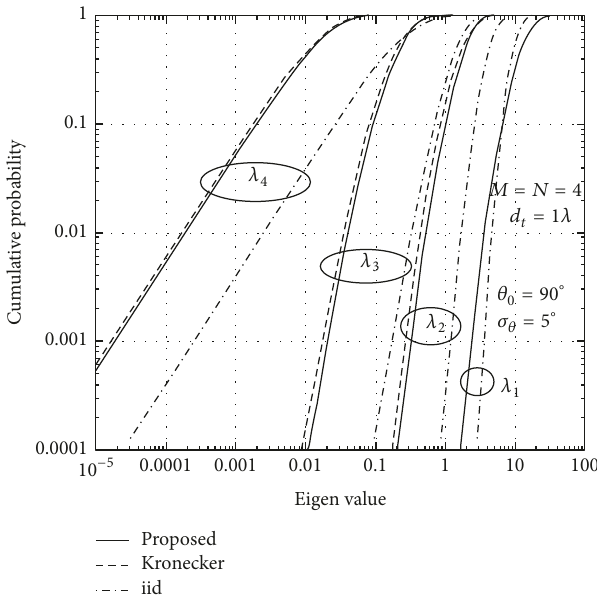
Figure7:EigenvaluecharacteristicswhentakingtheTX-sidespatial correlation into consideration.